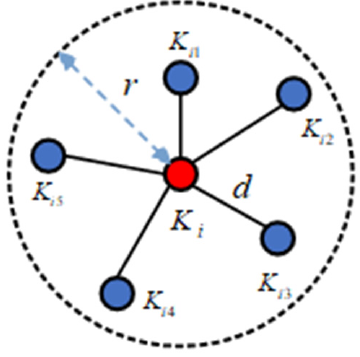
Figure 3. Diagram of neighborhood point distances.